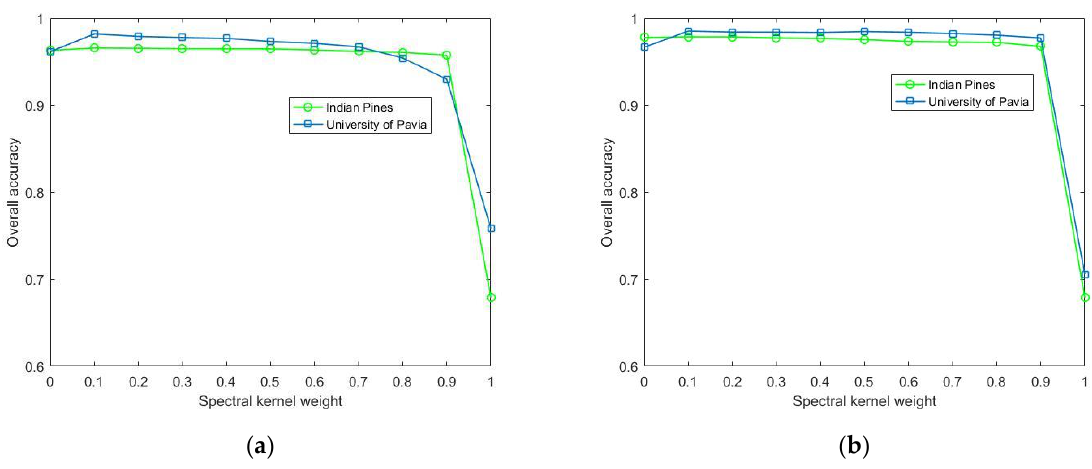
Figure 7. OA values under different spectral kernel weights. ( a ) WASCK; ( b ) MWASCK.